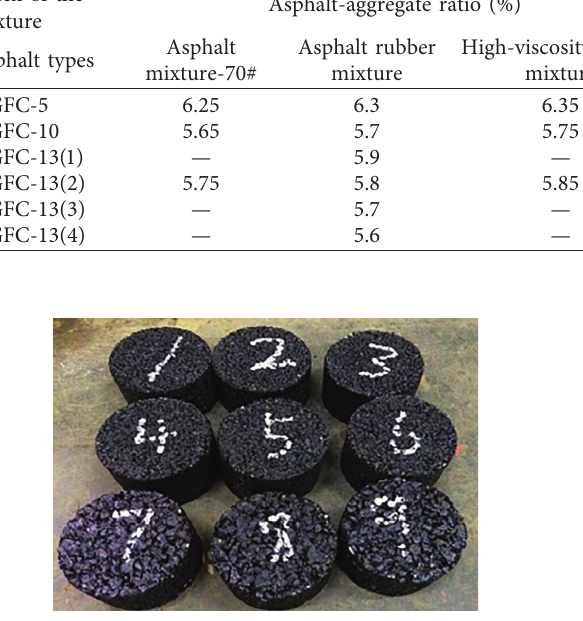
Figure 1: Marshall specimens.